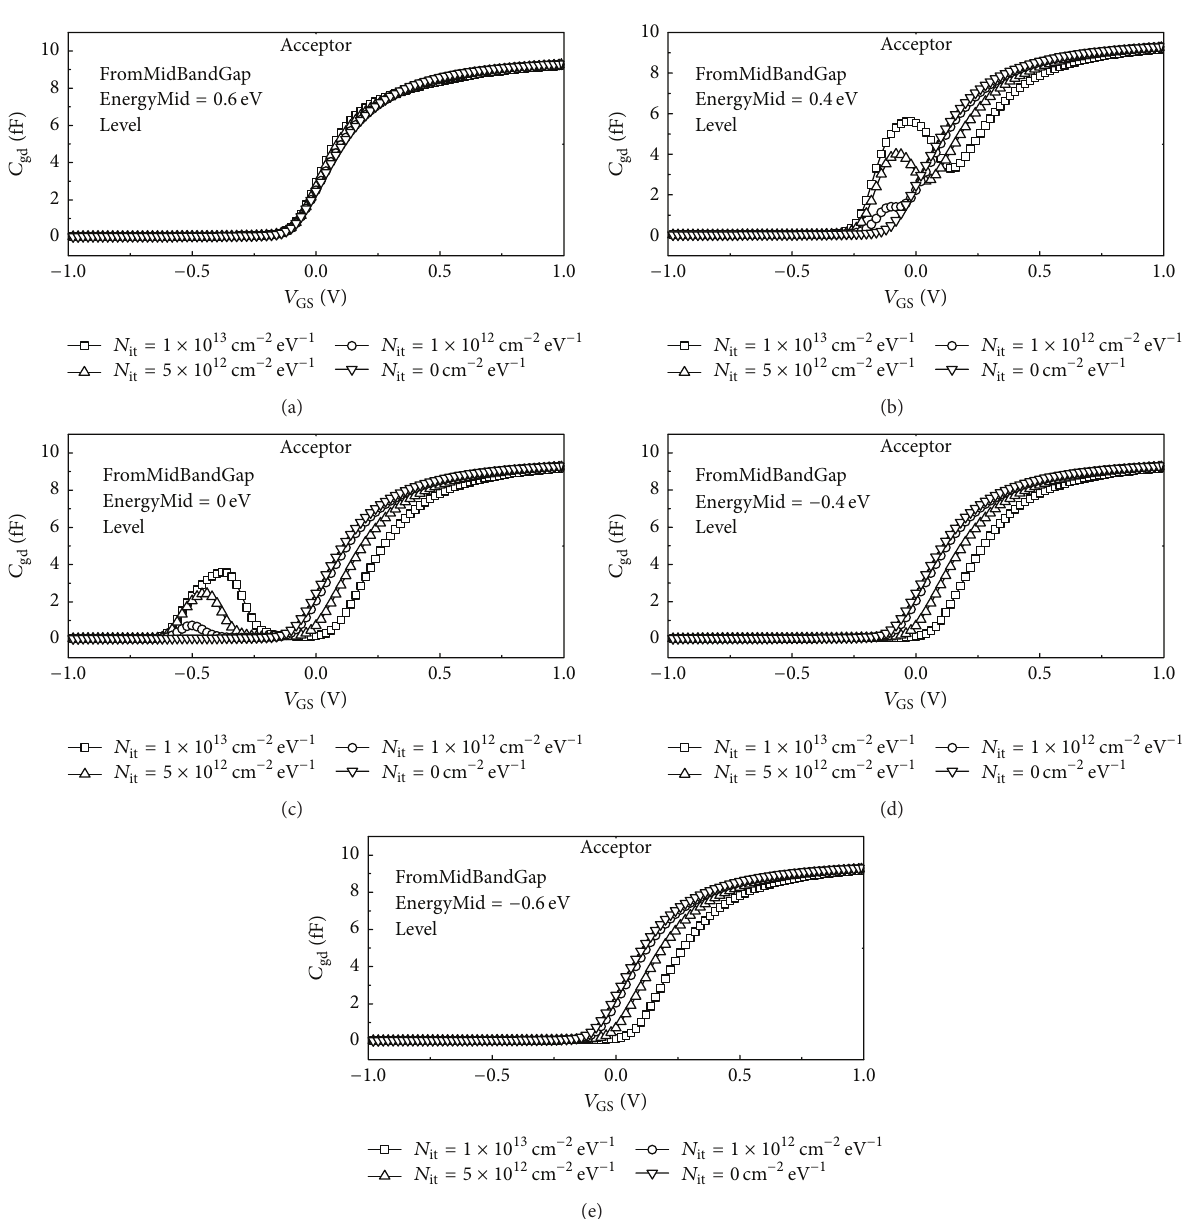
of DG-TFET for acceptor-type ITs is studied at 𝑉 gd